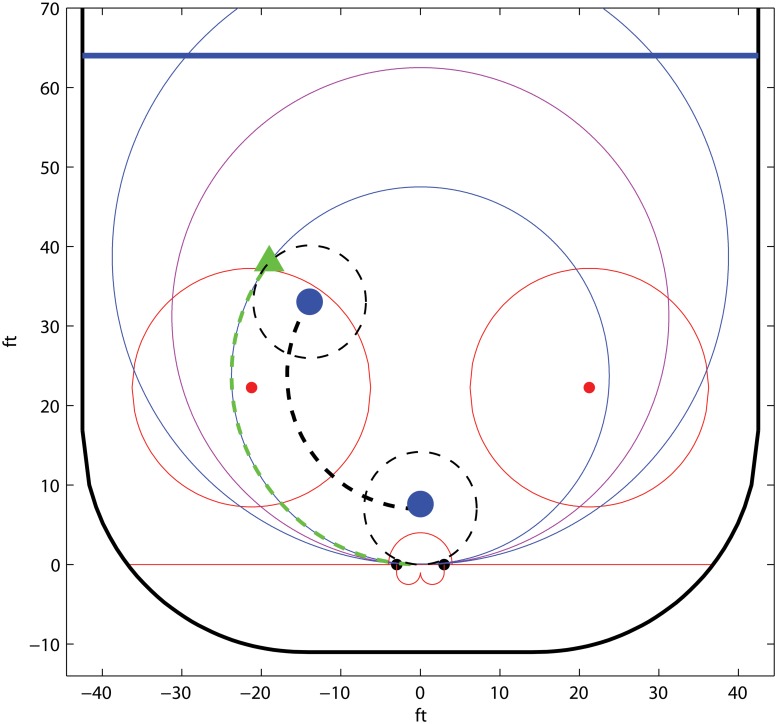
The optimal B
1 strategy for the example Ice hockey; eccentric isolines.The offensive starting position is denoted by a triangle and the defensive positions are denoted by circles. Here B
1 has critical speed vB=vA(rA−r)rA and the present isoline is circular.